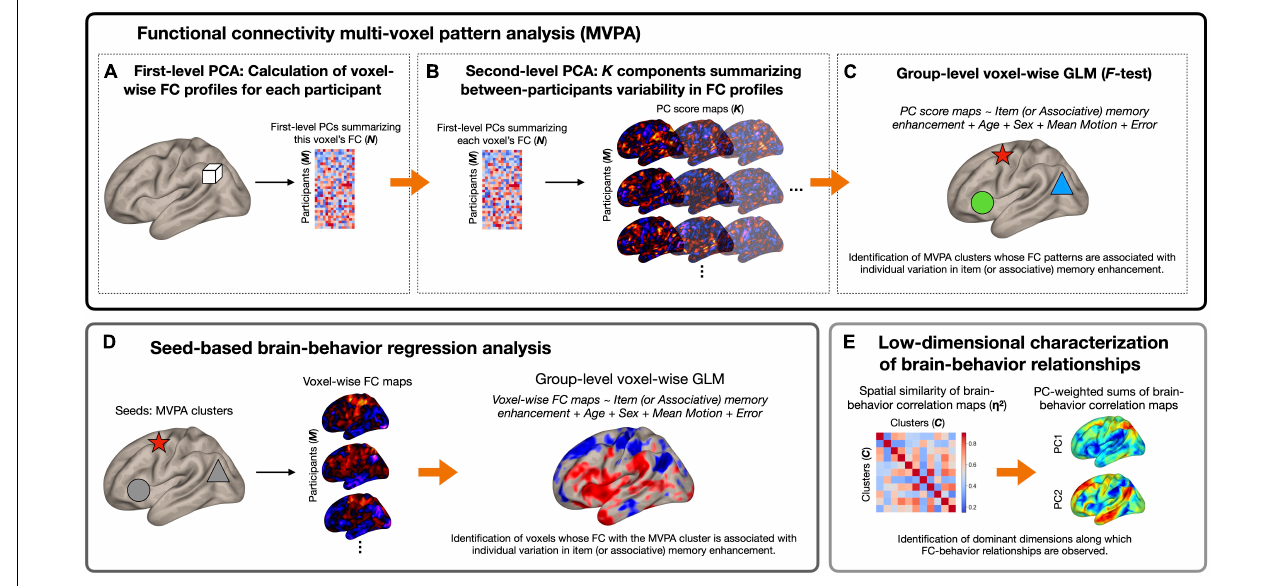
FIGURE 1 | Schematic diagram of the analytical pipeline. (A) For each voxel (represented here by a white cube) and for each participant separately, first-level principal component analysis (PCA) was performed to derive 64 components summarizing the pattern of functional connectivity between the voxel and every other voxel in the brain. Participant-wise principal component scores were concatenated across all participants, a M (269 participants) × N (64 components) matrix per voxel. (B) Second-level PCA was performed on voxel-wise principal component matrices generated in (A) , which resulted in K (seven) principal component score maps per participant that characterize most of the between-subjects variability in functional connectivity patterns. (C) Principal component score maps generated in (B) were used as inputs to second-level general linear model (GLM) analysis ( F -test) to identify brain regions whose functional connectivity patterns were associated with individual variation in the magnitude of item or associative memory enhancement by affect (represented here by shapes with different colors). (D) Seed-based regression analysis was performed using the MVPA clusters as seeds. This analysis revealed—for each MVPA seed—the topography and direction of functional connectivity differences associated with each behavioral measure. (E) As the final step, PCA was performed on brain-behavior regression maps to derive a low-dimensional representation of brain regions whose functional connectivity patterns were associated with memory enhancement. Arrows represent the progression of data within and between analysis steps. In the matrices and brain maps, warmer colors represent more positive values, while cooler colors represent more negative values. FC, functional